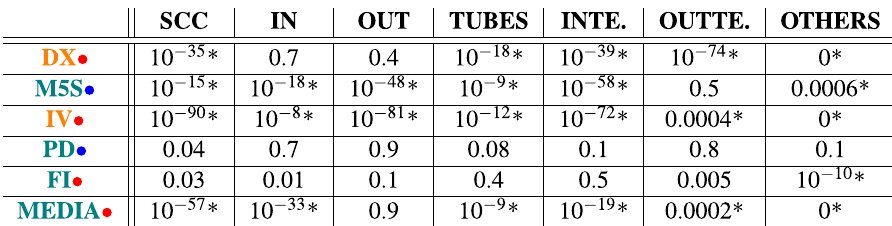
Table 1. p-values related to the various bow-tie sectors in the COVID-19 Italian dataset. In orange strong bow- ties, while in teal weak ones; red dots indicate OUT-dominant bow-ties, blue dots indicate INTEND-dominant ones. If we set the statistical significance to α = 0.01 , then we then have to correct for multiple hypothesis testing per block. In the present case, we used the False Discovery Rate method (FDR 78 ). In the table, validated p-values are marked by an asterisk ‘ ∗ ’. The OTHERS block is statistically significant (in particular it is smaller than in the randomization) for all discursive communities but the PD one. It is remarkable that the dimension of SCC is significant in all strong bow-ties, while the one of OUT is significant only for IV bow-tie.